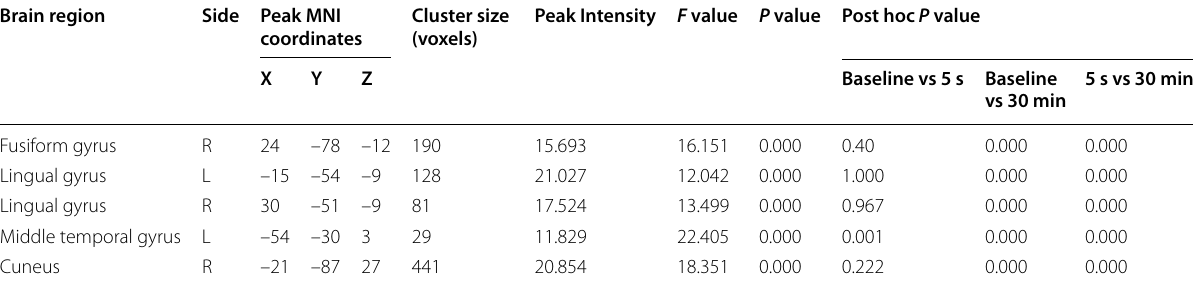
Table 4 Regions with dynamical amplitudes of low-frequency fluctuations in patients with CTN